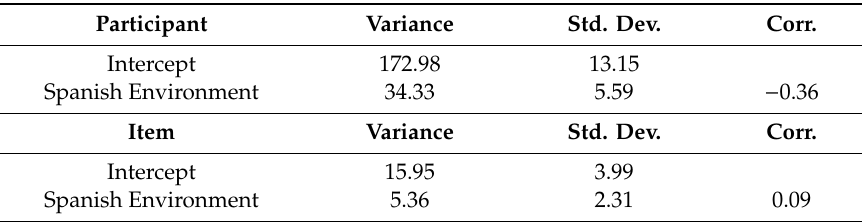
Table A1. Voice Onset Time Model Random E ff ects. Participant